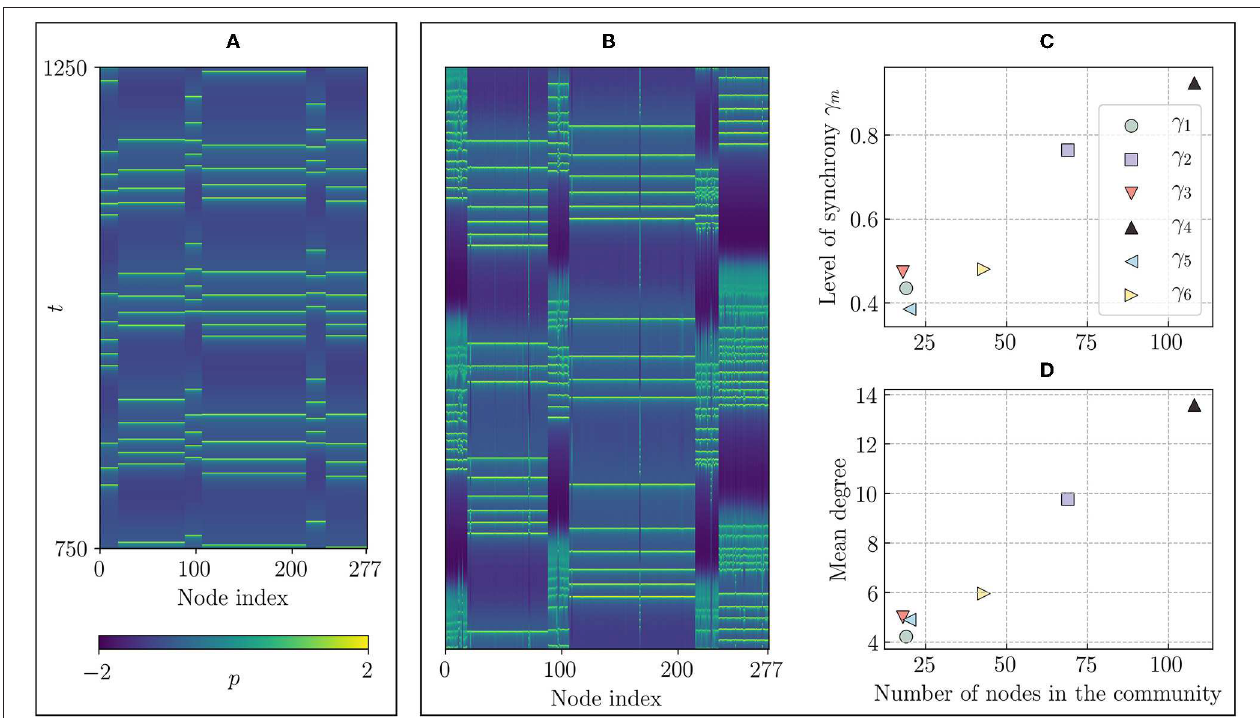
FIGURE 4 | Space-time plots of the designed network. (A) Time series of the p -variables for a state in which every community is internally synchronized. The nodes are ordered as in Figure 2 with communities 1 to 6 from left to right. This state is achieved for g el = 1.76, g ch = 0. Keeping the chemical coupling at g ch = 0 and decreasing the electrical coupling to g el = 0.4 leads to the timeseries in panel (B) , with the same color code and time scales as before, where the large communities (2 and 4) are more synchronized than the smaller communities. We call this a chimera-like state. (C) Level of synchronization γ m and (D) mean degree of each community ( m = 1, ... ,6), vs. the size of the community, respectively, indicating a strong correlation between size and order. Parameters as in Figure 3